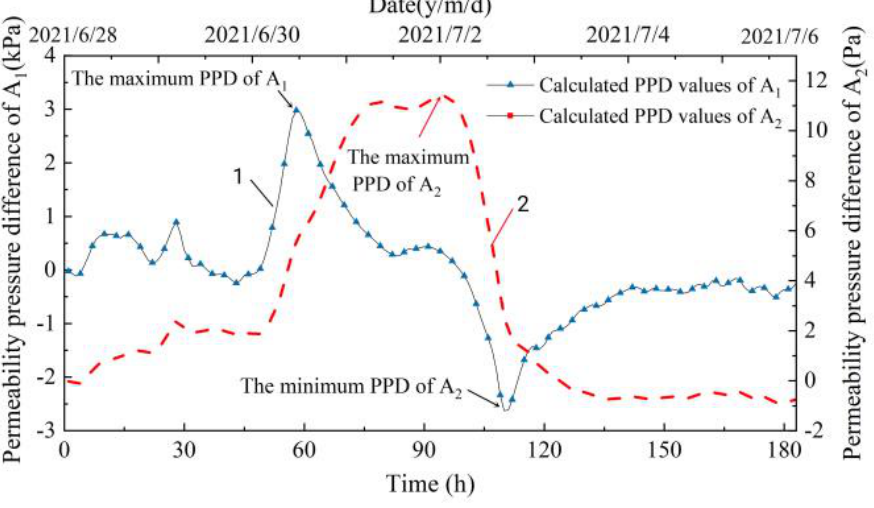
Figure 14. Transient change curve of permeability pressure difference at A 1 and A 2 points on both sides of ancient riverbank antiseepage wall.